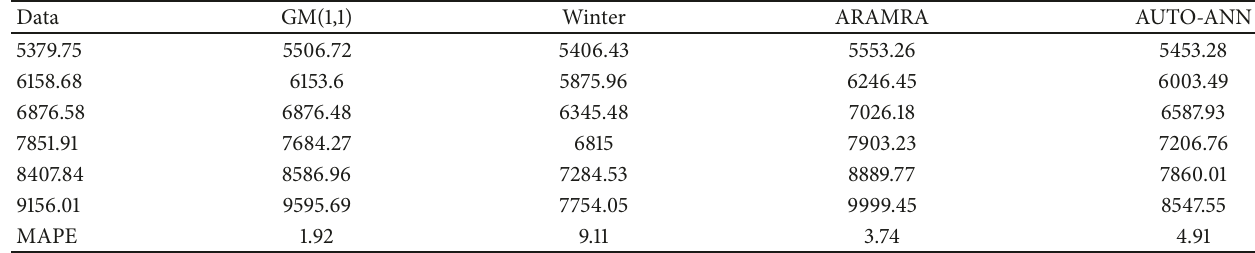
Table 4: The results for different models for M3C N1.